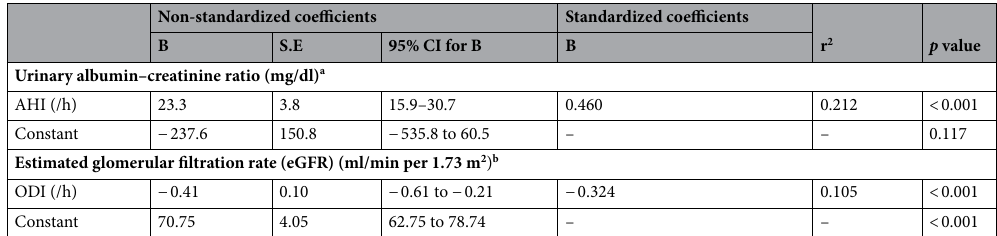
Estimated glomerular filtration rate (eGFR) (ml/min per 1.73 m 2 ) b ODI